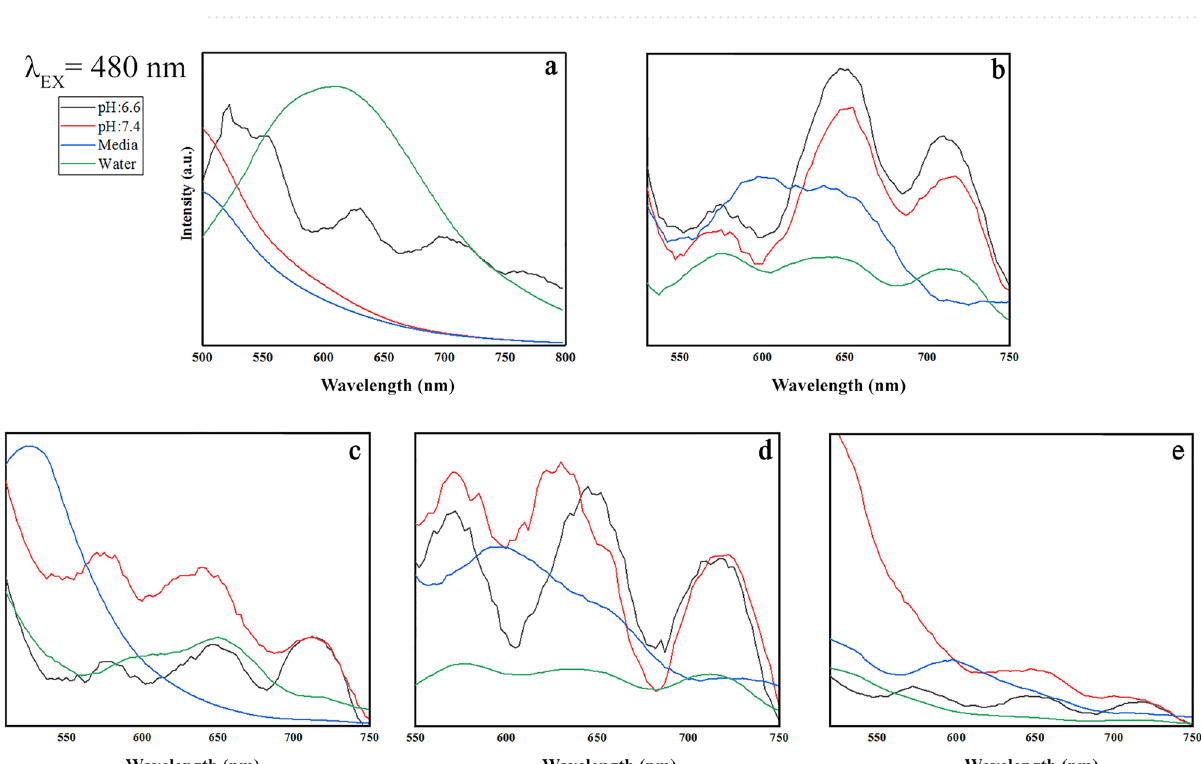
Figure 4. Emission pattern of ( a ) GO, ( b ) GO-PEG, ( c ) GO-PEG-Fe 3 O 4 , ( d ) GO-PEG-Au, and ( e ) GO-PEG-FA at the excitation wavelength of 480 nm in water, cell media (DMEM), PBS at two different pH values (pH 6.6 and